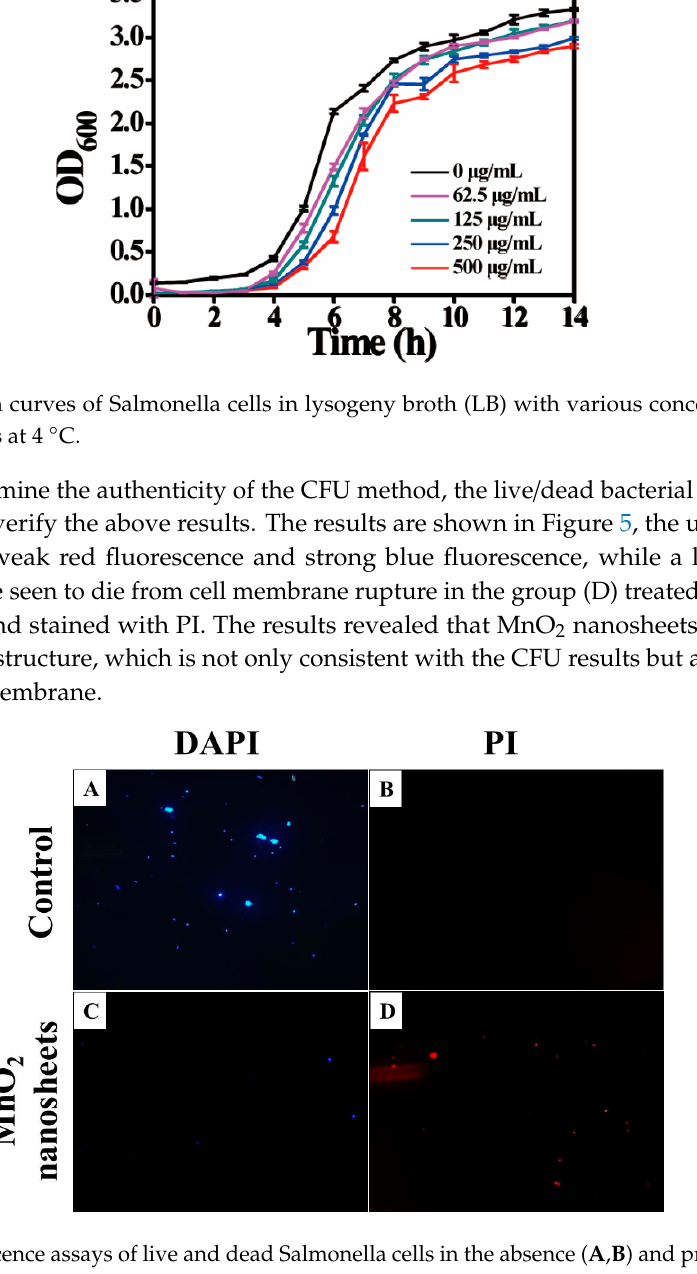
Figure 3. In vitro antibacterial activity test. ( A ) Cell survival rate of Salmonella cells treated or